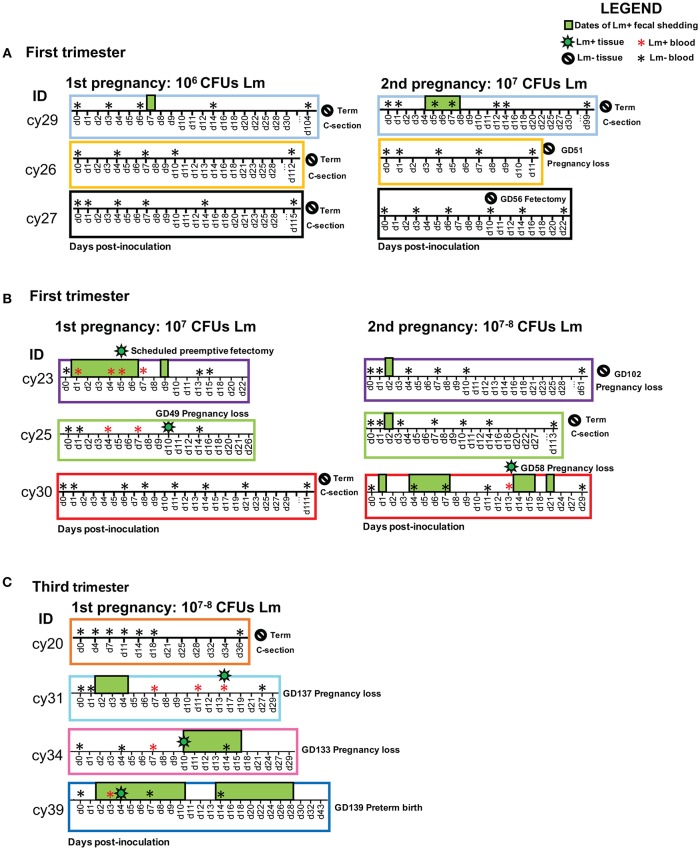
Experimental timelines for each cohort showing animal ID, sample collections, and pregnancy outcome. The x-axis displays post-inoculation days. The following symbols indicate events on the timeline: positive blood culture (red asterisk), negative blood culture (black asterisk), positive tissue culture (green bacteria), negative tissue culture (negative sign), and positive fecal culture (green box). Fecal samples were collected on each date shown on the timeline; dates without a green box denote negative fecal cultures, and absent dates indicate that no samples were collected. Overlapping symbols indicate concurrent events. (A) First trimester cohort: 106 CFUs Lm initial dose; 107 CFUs Lm reexposure. (B) First trimester cohort: 107 CFUs Lm initial dose; 107 CFUs Lm reexposure. (C) Third trimester cohort: 107–108 CFUs Lm dose.